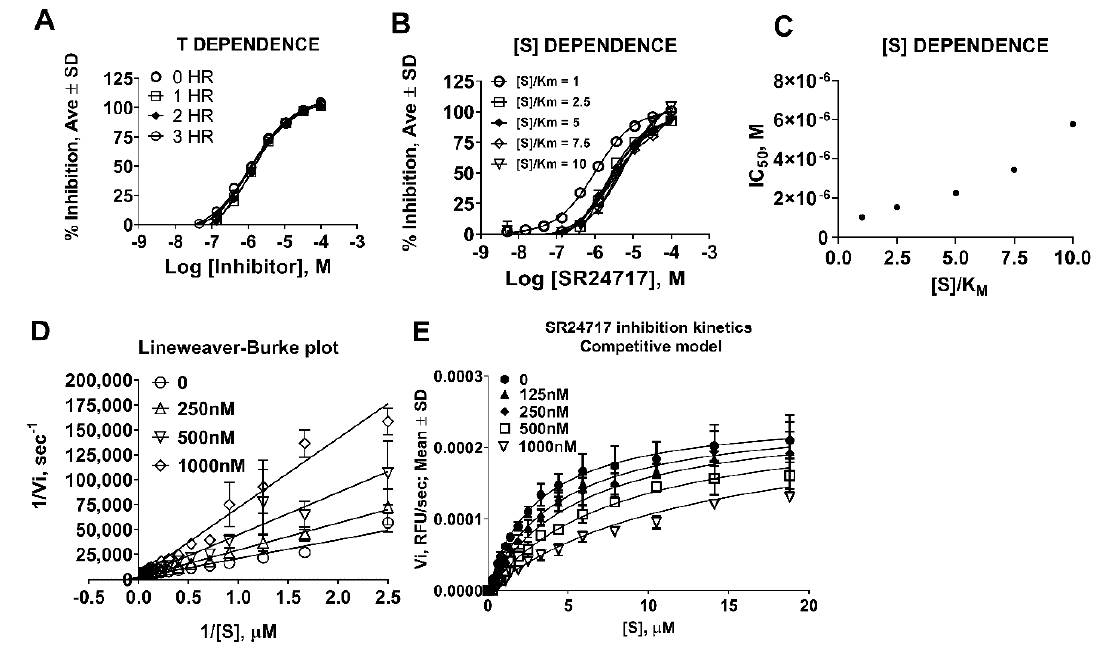
Figure 5. Characterization of mode of meprin α inhibition by potential probe. SR24717. ( A ) Time-dependence study of inhibition of meprin α -mediated proteolysis by SR24717. ( B ) Concentration-dependence study of meprin α inhibition- mediated proteolysis by SR24717. ( C ) Re-plot of ( B ) shows increase of IC 50 values correlating with increase of substrate concentration suggestive of competitive inhibition mechanism by SR24717. ( D ) Lineweaver-Burke plot shows lines of best fit crossing at Y-axis, suggesting a competitive inhibition mechanism by SR24717. ( E ) Global fit of meprin α -mediated proteolysis in the presence of SR24717 to a competitive model using non-linear regression shows good fit.